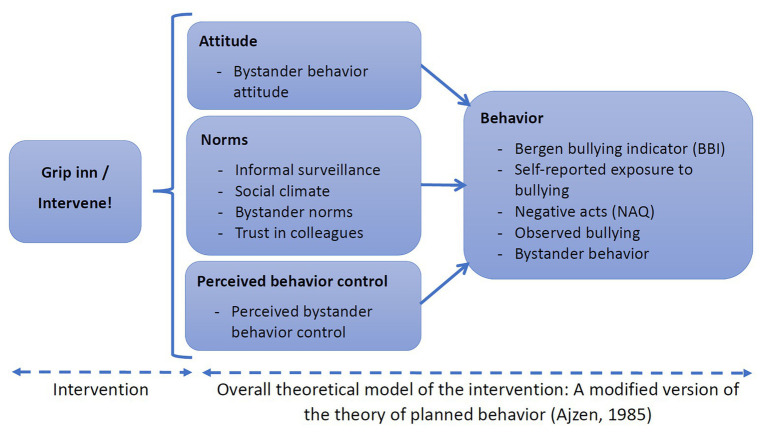
The theoretical model for the intervention is based on a modified version of the theory of the planned behavior (TPB; Ajzen, 1985).